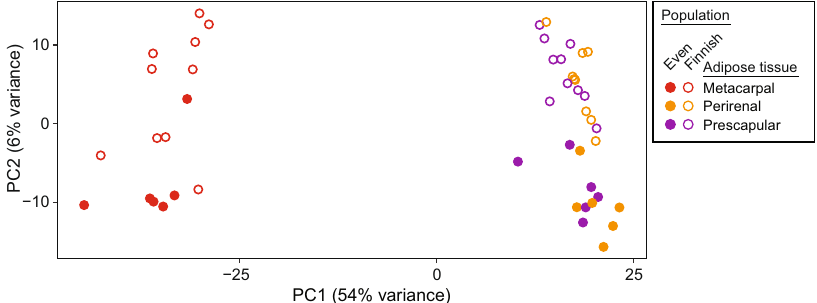
Fig. 2 PCA plots of the analysed samples based on expression pro fi les, with dot colours indicating tissue and region (see legend). The adipose tissue samples are labelled with red (metacarpal), yellow (perirenal), and violet (prescapular) colours. The solid dots represent the Even reindeer samples and the circles the Finnish